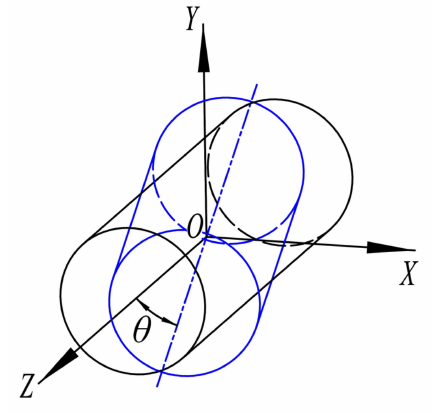
Figure 14. Schematic of the skewing angle.